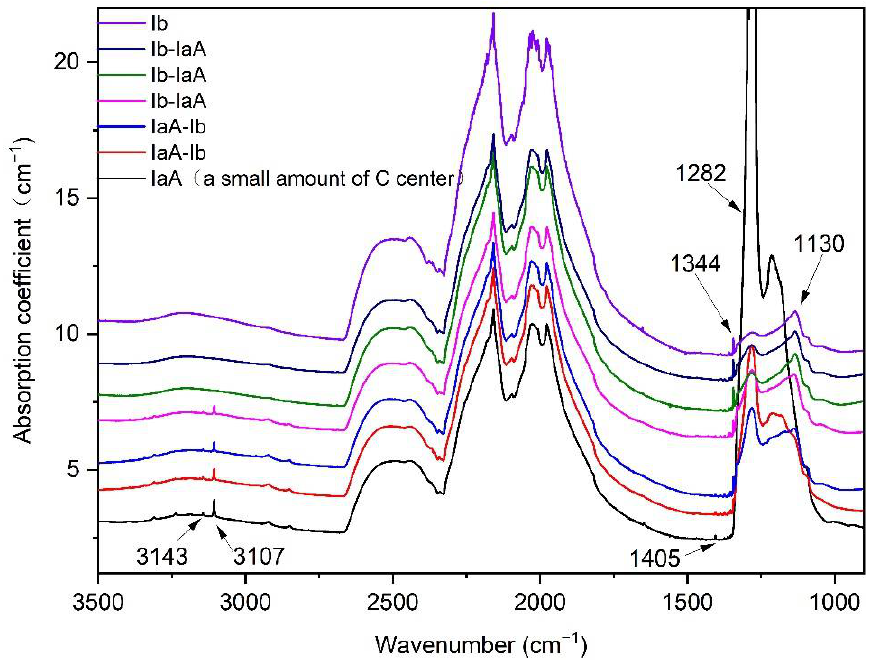
Figure 1. The absorption spectrum of type I natural diamonds with different nitrogen concentrations.